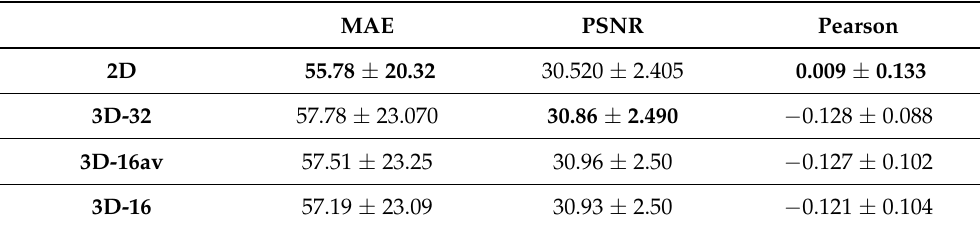
Table 24. Pelvis dataset Fat with Residual-net. Mean Absolute Error, PSNR and Pearson coefficient from Residual-net using different convolutions and reconstructions in the Pelvis data set within the fat.